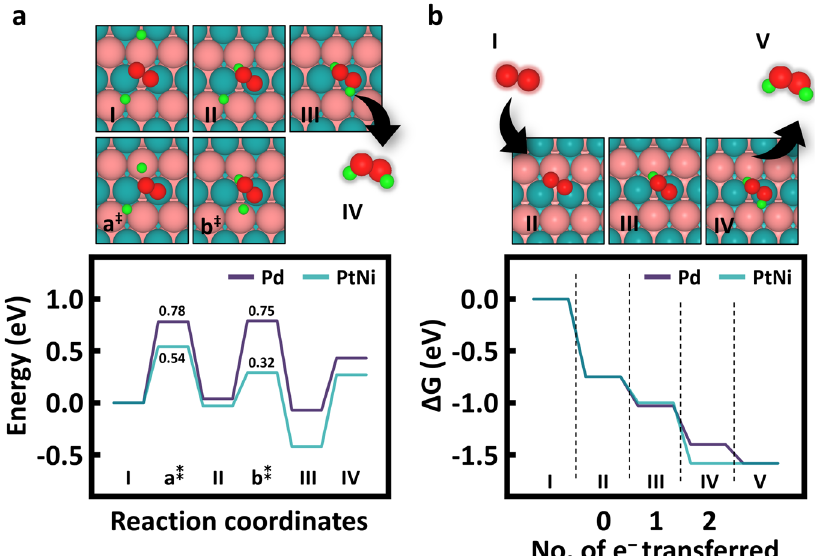
Fig. 5 H 2 O 2 direct synthesis mechanisms of Ni 50 Pt 50 (111) and Pd(111) from DFT calculations. a The Langmuir-Hinshelwood mechanism. b The electron – proton transfer mechanism. The cyan lines are the energy diagram for Ni 50 Pt 50 (111), and the magenta lines are for Pd(111). The color code for the atoms is as follows: teal = Ni, coral = Pt, red = O, and green =